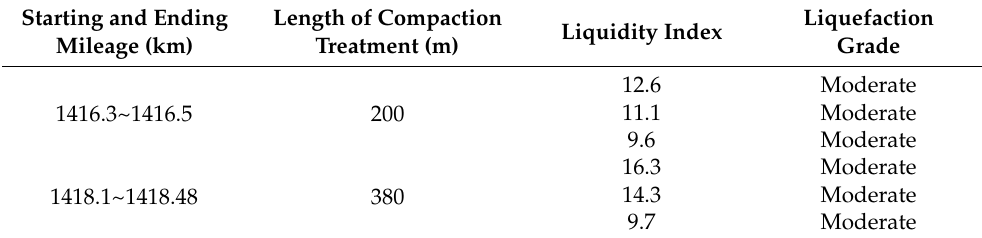
Table 1. Liquidity indices at a depth of 8.0 m after dynamic